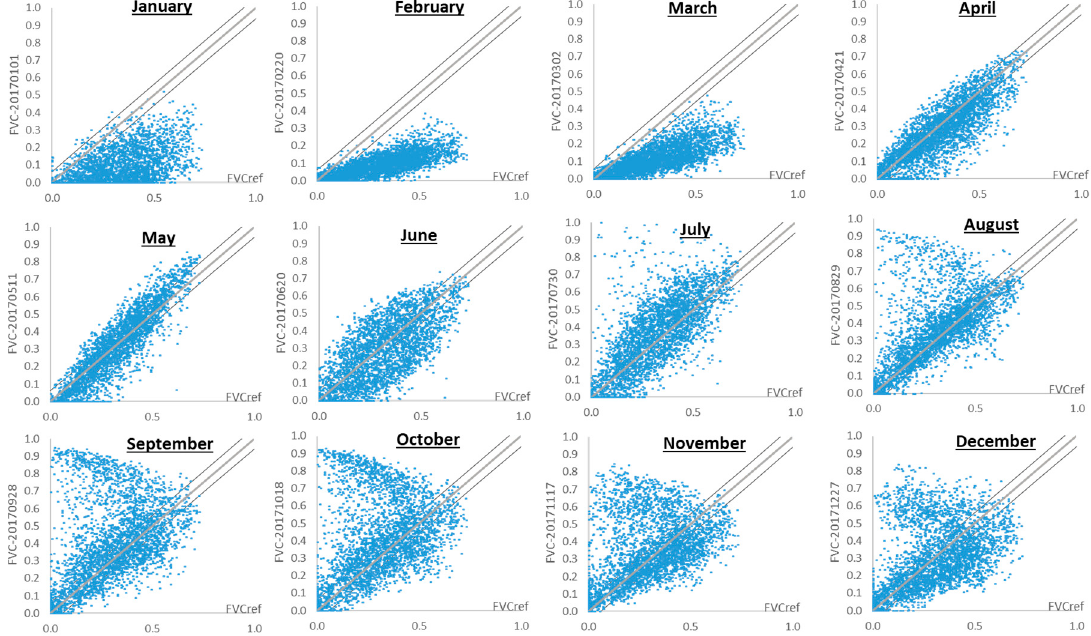
Figure 7. Monthly dynamics of fractional vegetation cover (FVC) in 2017 in relation to the FVC of the reference image (FVCref).